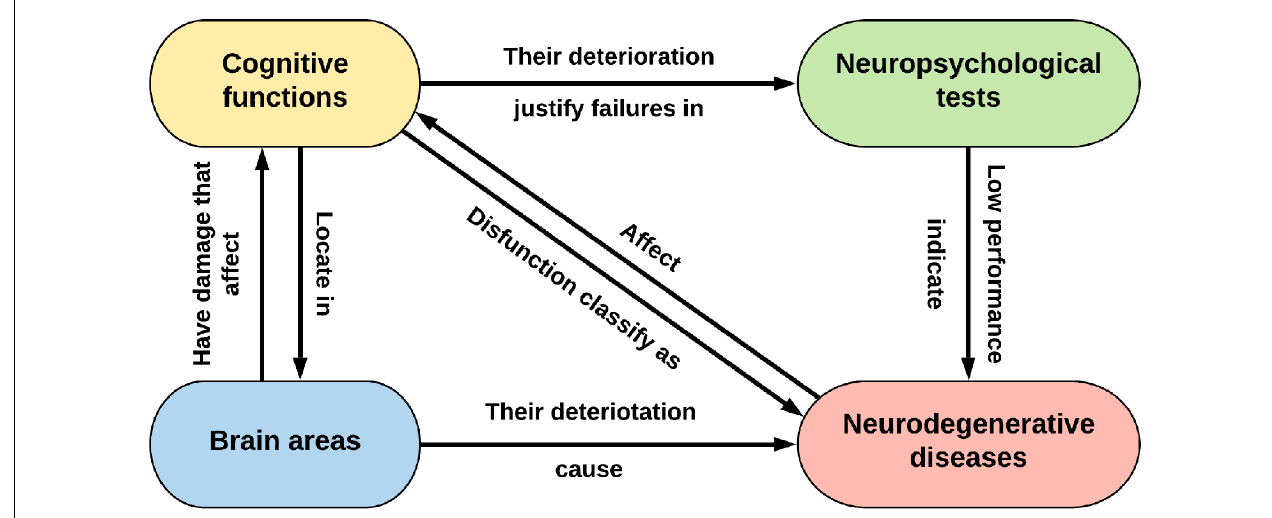
FIGURE 1 | Scheme of the relationship between the four major domains of the ontology. It would also be completed with the other transversal information of interest, such as medical history, risk factors, or possible